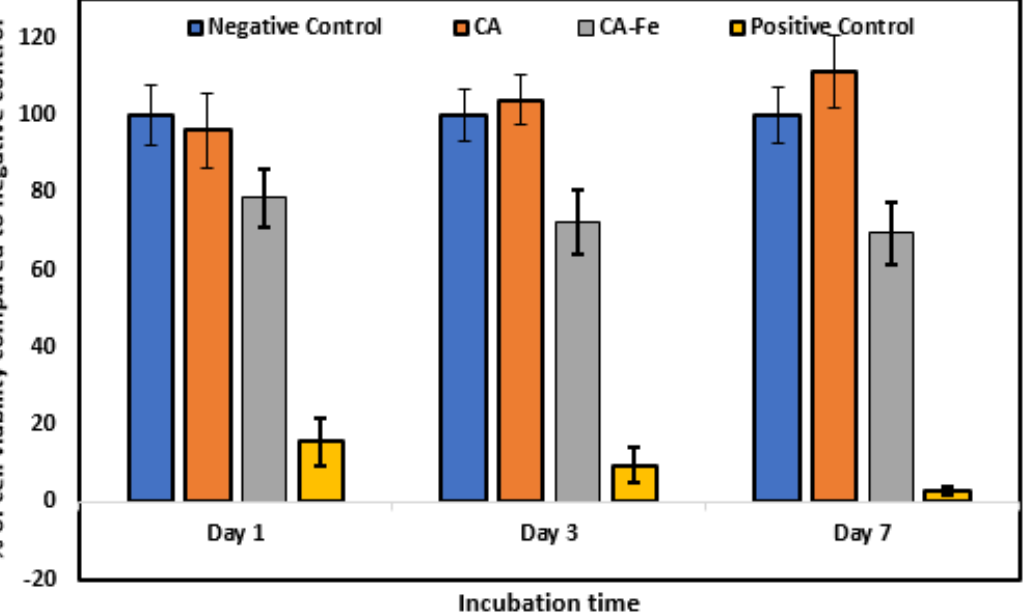
Figure 7. Cytotoxicity evaluation by indirect contact assay. The effect of the extracts of CA and CA/Fe on human fetal osteoblasts cultured for 1, 3, and 7 days measured by the MTT assay. Results are presented as means ± standard deviation (n = 8).